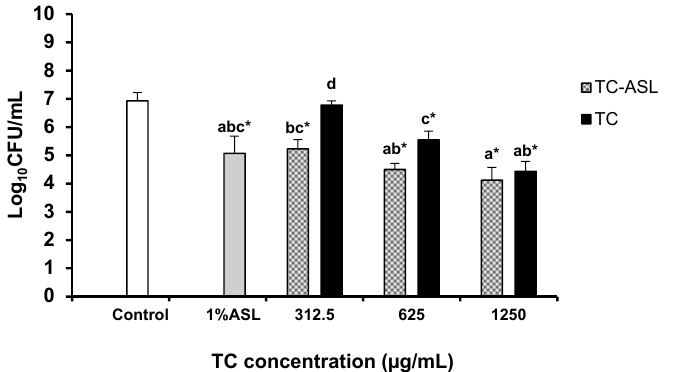
Figure 3. Cell count of E. faecalis biofilm after treatment with TC–ASL, TC, and 1% ASL. The cell count was expressed in log 10 CFU/mL. The results represent the mean ± SD of three replicates in independent experiments. Different letters denote a statistically significant difference ( p ≤ 0.05) between different treatment groups while the same letters show no statistical difference ( p > 0.05) between different treatment groups, including the within-group comparison and between-group comparison. * Denotes a significant difference compared to the control ( p ≤ 0.05).